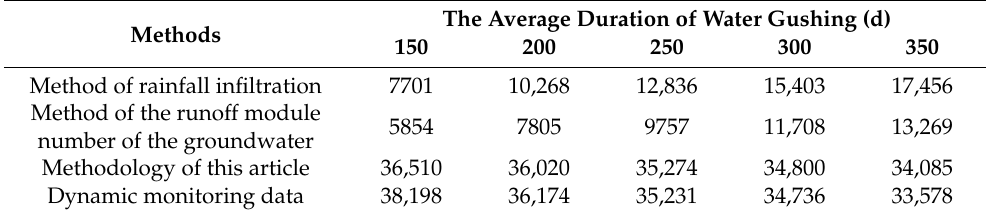
Table 2. Comparative analysis of water gushing.